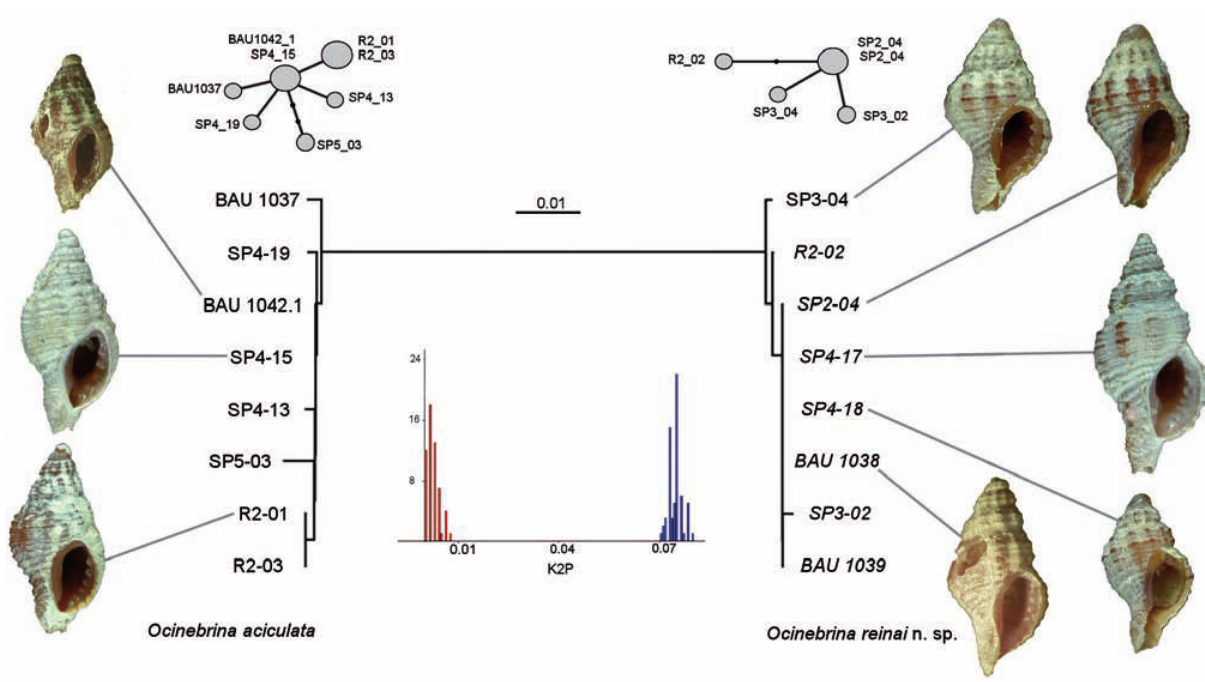
Fig . 4. – Neighbor-joining tree for specimens of O. aciculata and O. reinai n. sp. from Secche di Tor Paterno (Central Tyrrhenian Sea). Scale bar: 1% K2P genetic divergence. Histograms report K2P genetic divergence in intraspecific (left) and interspecific (right) comparisons. Network of haplotypes based on statistical parsimony